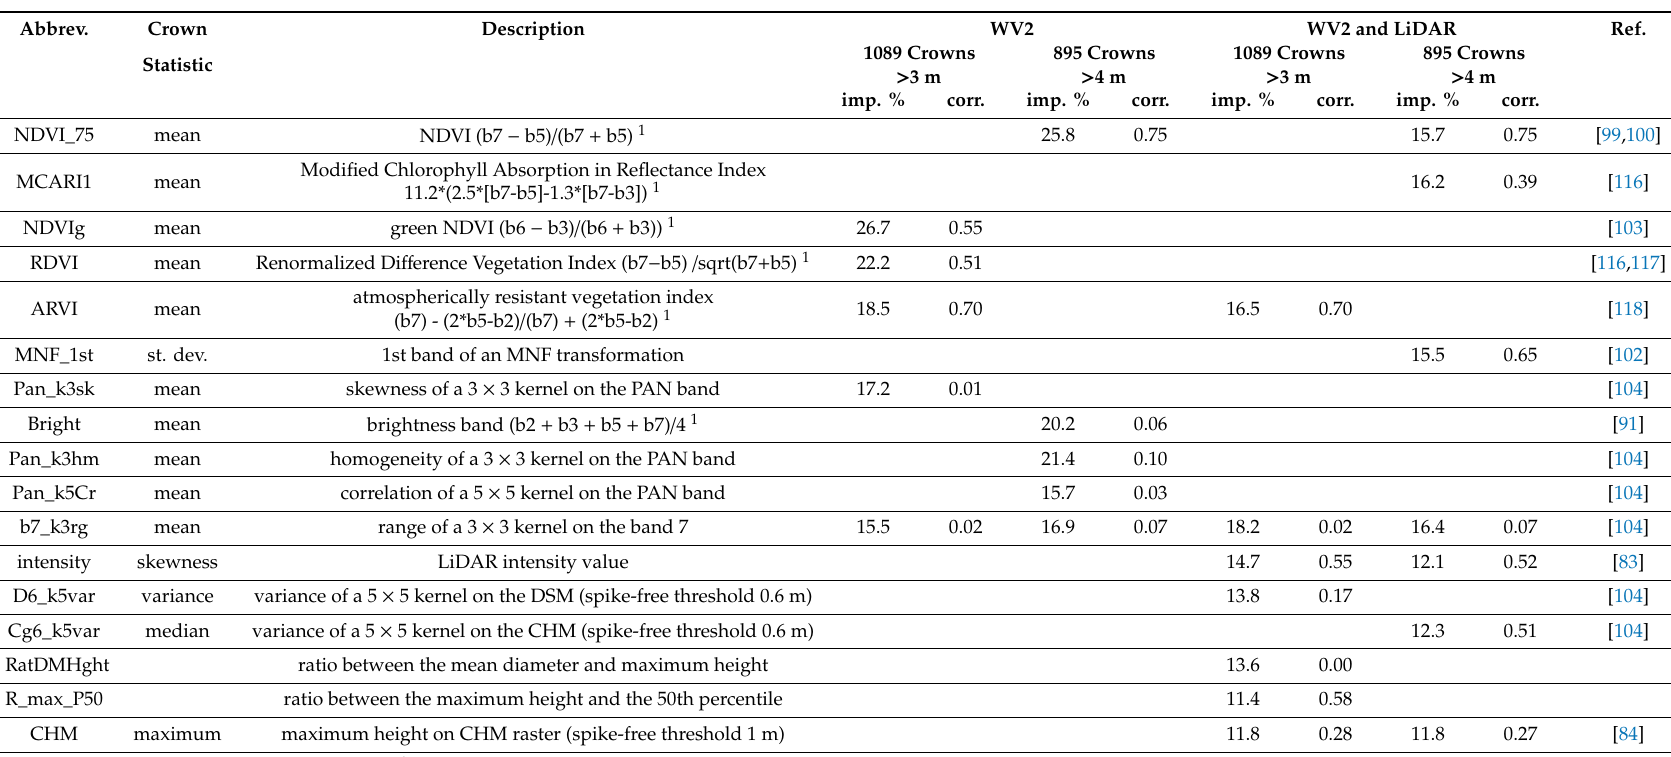
1 The variables marked with “b” indicate the band numbers of the WV2 image according to Table